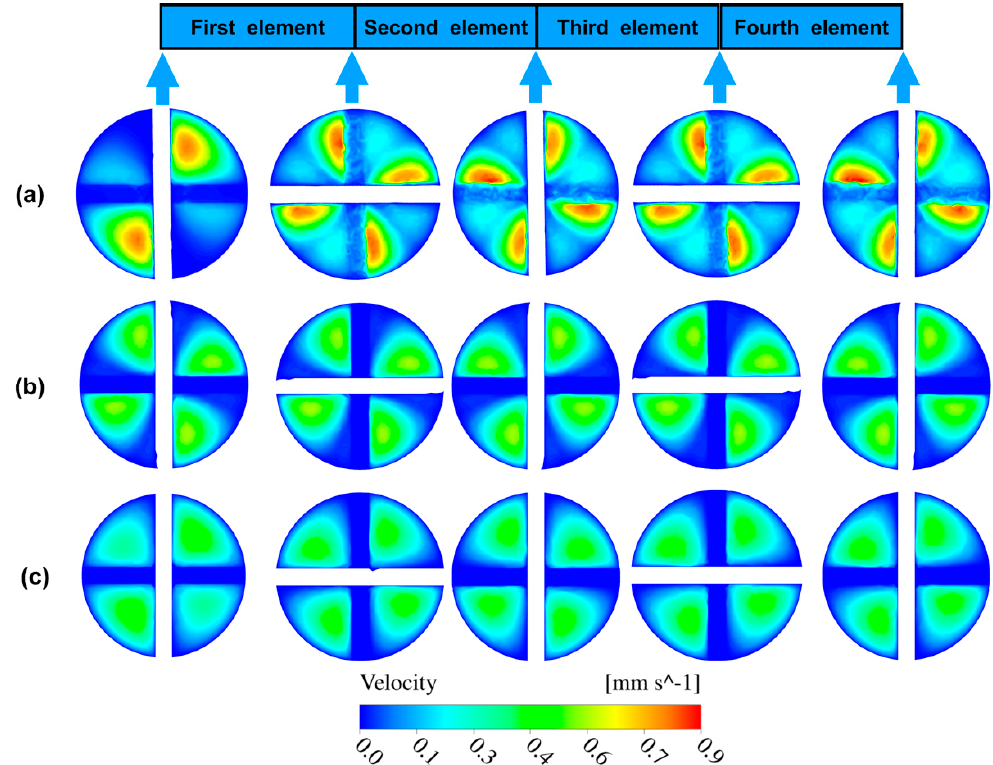
Figure 6. Effect of aspect ratio on cross sectional profiles of velocity at Re = 1: ( a ) AR = 0.4; ( b ) AR = 0.8; ( c ) AR = 1.5.